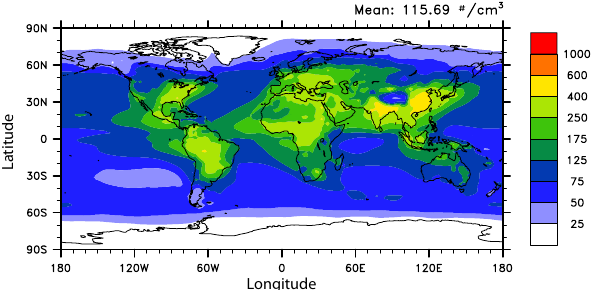
Fig. 5. Annual averaged global distributions of CCN concentrations (numbercm − 3 ) at 0.1% supersaturation in the lowest model layer.